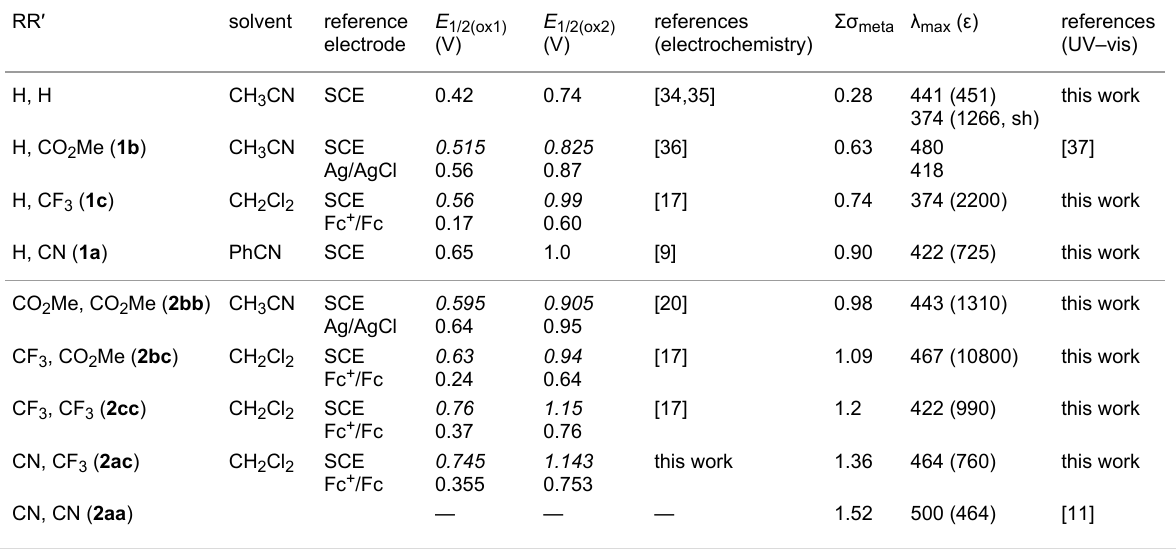
Table 1: Electrochemical and spectroscopic data of the EDT-TTF-RR ′ derivatives 1 and 2 . Reported values with other electrochemical references were converted to approximate values vs SCE and are given in italics. Potentials reported vs Fc + /Fc were converted to SCE by adding 0.39 V. Poten- tials reported vs Ag/AgCl were converted to SCE by adding − 0.045 V. Lowest energy absorption maximum λ max (nm) and molar extinction coefficient ε (L·mol − 1 ·cm − 1 ) are determined in CH 2 Cl 2 unless otherwise specified).